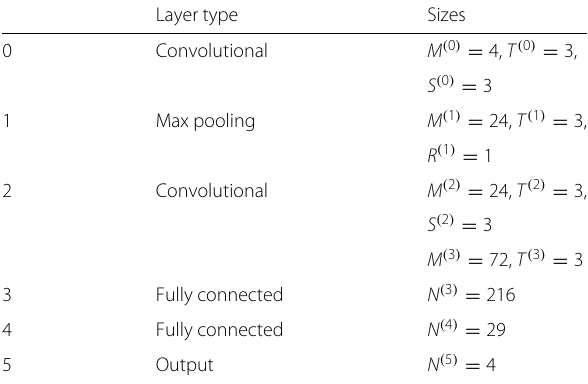
Table 8 Layers of final classifier neural network for SCADA